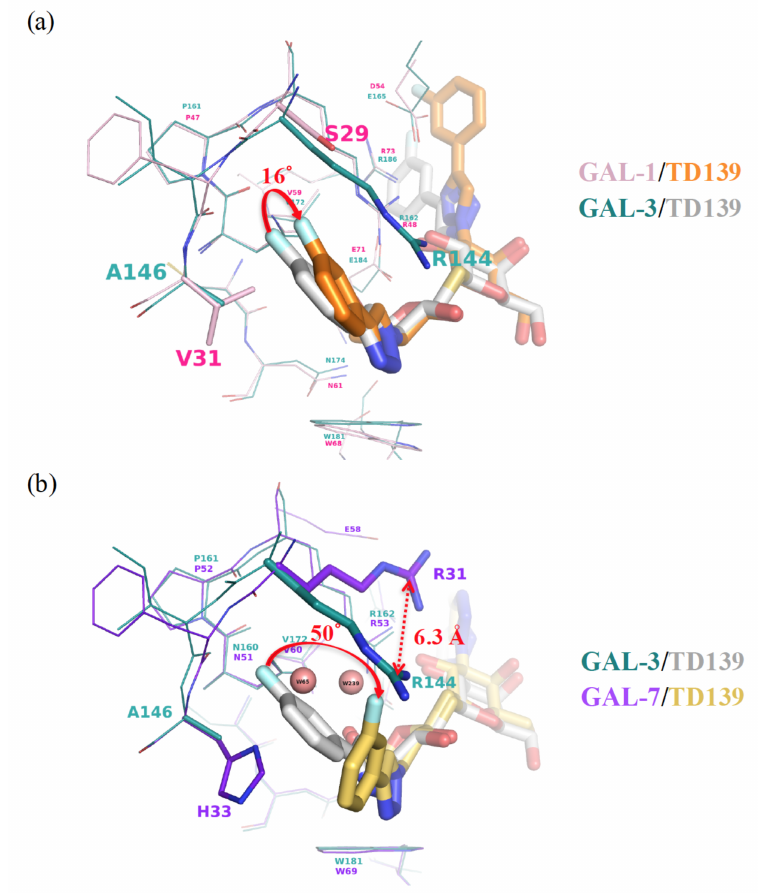
Figure 7. ( a ) Structural superimposition of the GAL-1 (pink)–TD139 (orange) complex and GAL-3 (deep teal)–TD139 (gray) complex. Val31 of GAL-1 is bulkier than the corresponding residue (Ala146) in GAL-3, and the 4-fluorophenyl moiety is forced to rotate approximately 16 ◦ . ( b ) When the structures of GAL-3 (deep teal)–TD139 (gray) and GAL-7 (purple blue)–TD139 (yellow orange) are superimposed, the fluorine atom of the 4-fluorophenyl moiety at GAL-7 B subsite turns approximately 50 ◦ away as compared to that in GAL-3. In addition, a large difference is observed between Arg144 GAL-3 and Arg31 GAL-7 , that are 6.3 Å